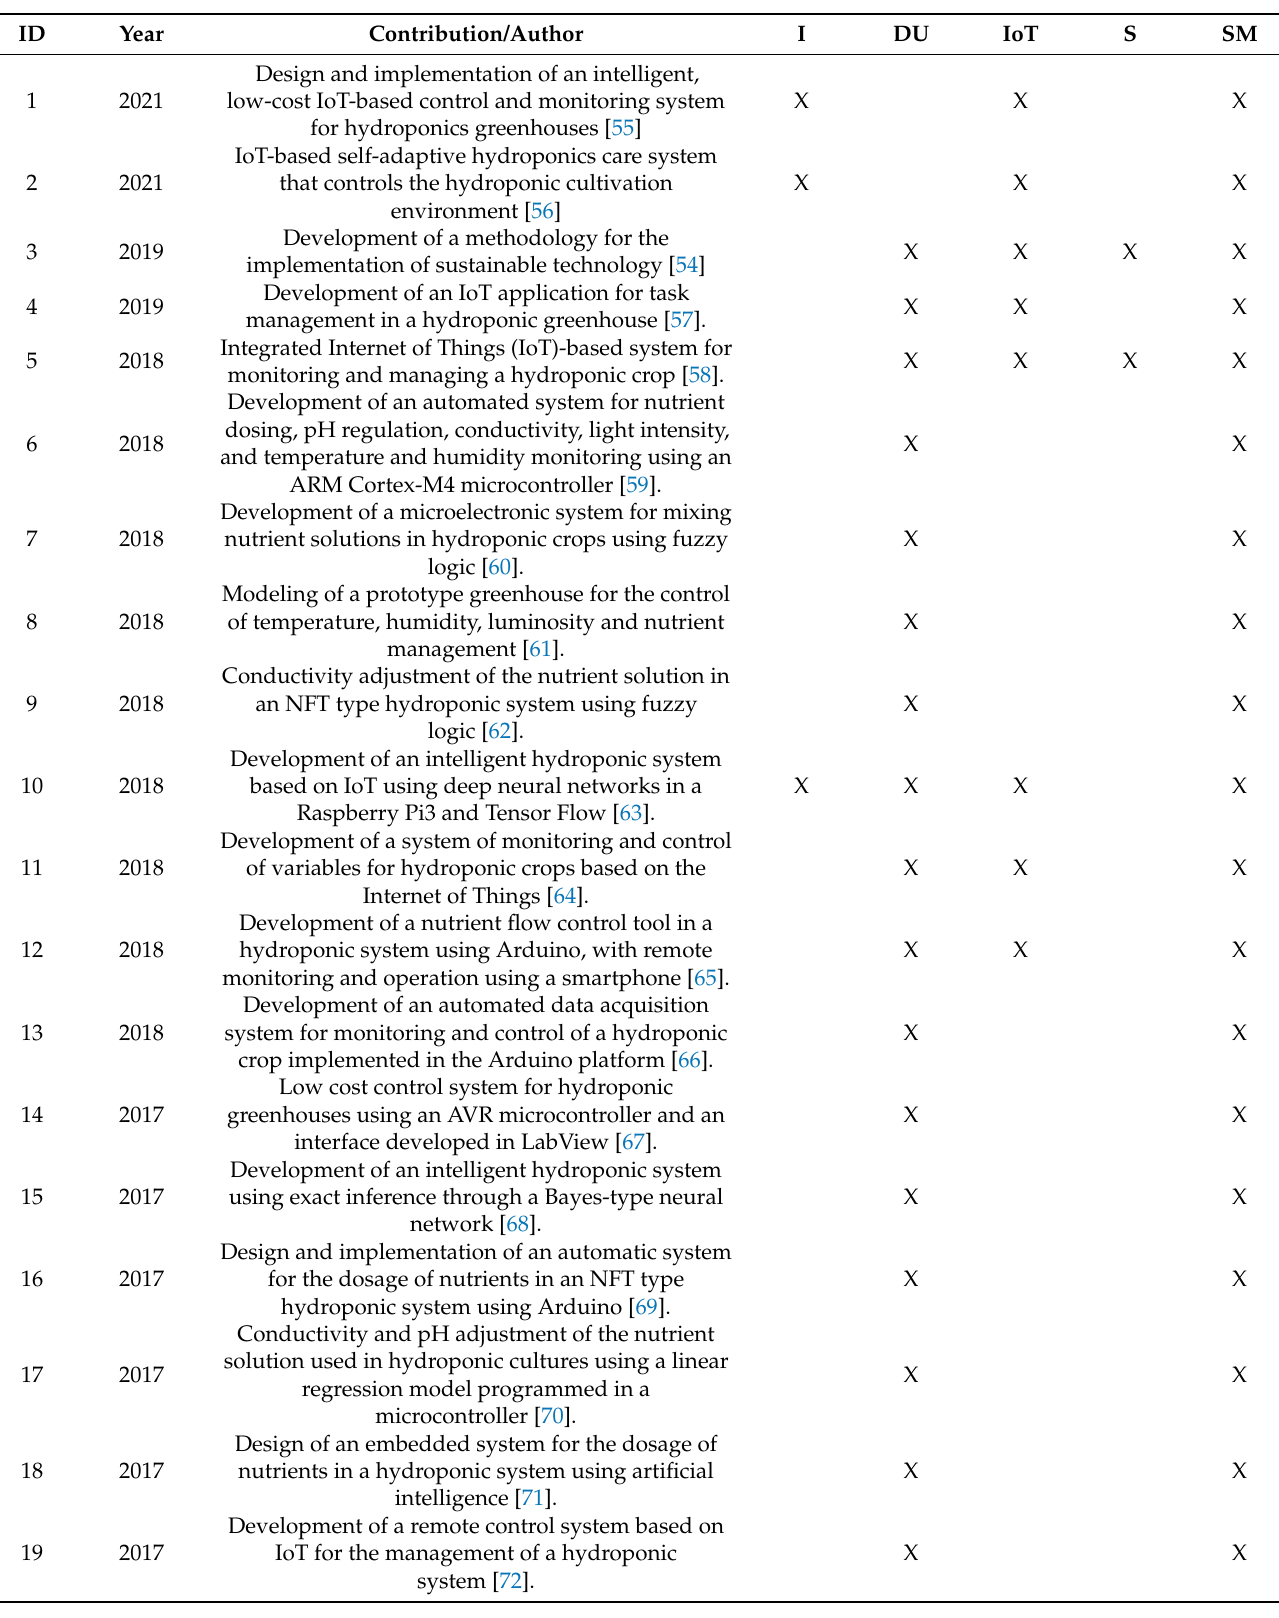
Table 6. Technological contributions to the automation of tasks in small hydroponic